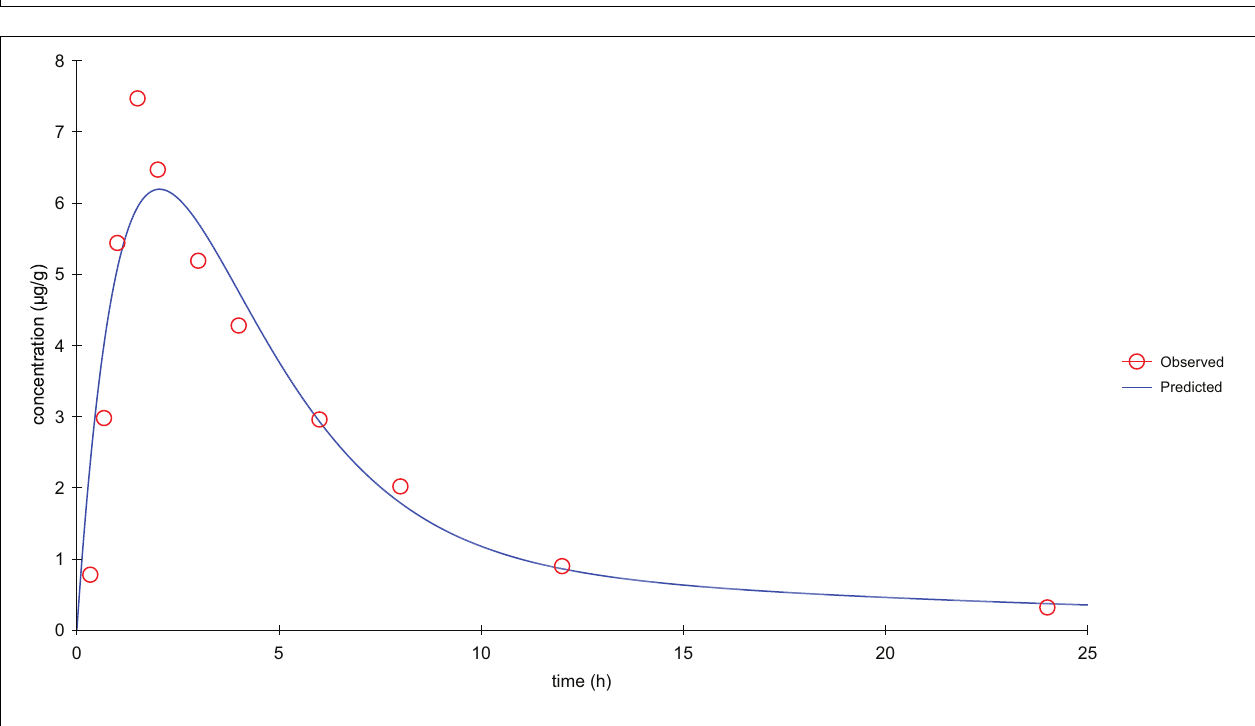
FIGURE 5 | Semi-logarithmic time curve of tylosin (25 mg/kg b.w.) in lung tissue of chicken by gastric administration.